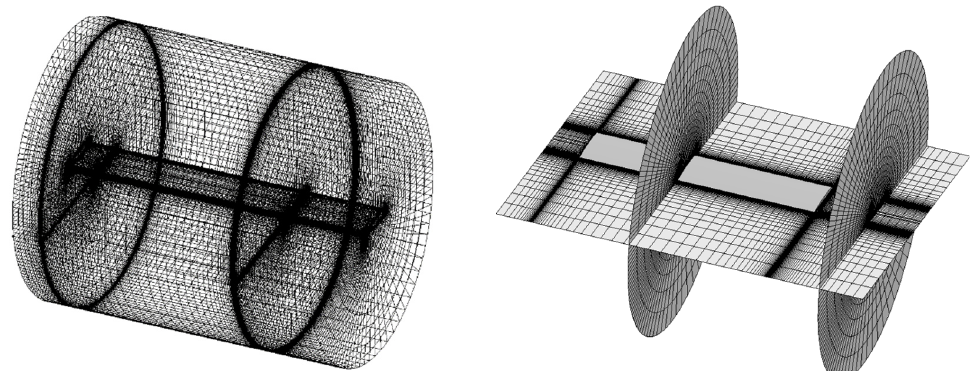
Figure 6. Three-dimensional blade body-fitted grid.